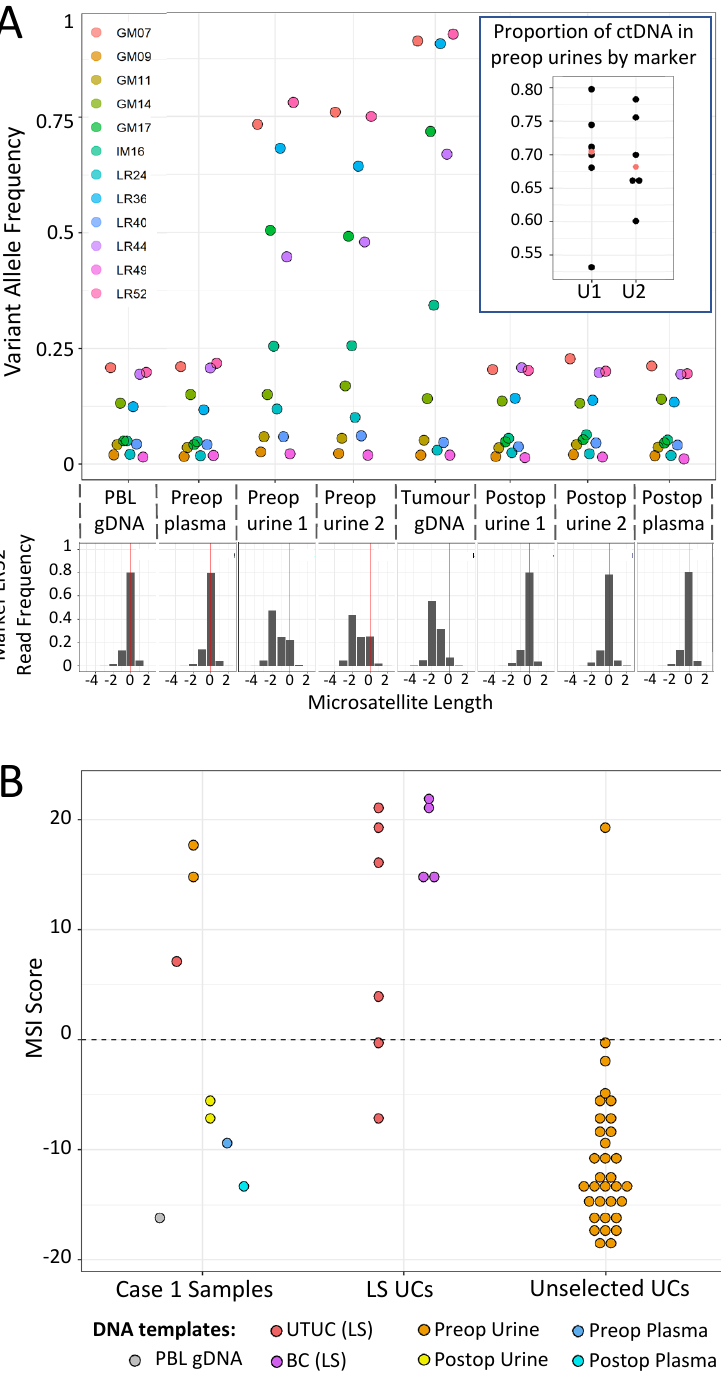
Figure 4. Analysis of Case 1 (LS UTUC patient) samples with the mPCR assay. ( A ) Top —VAFs for all 12 markers in patient samples (key gives marker names). Inset—Dot plot showing proportion of tumour-derived DNA within preop urine samples, based on 6 markers with increased VAFs. The median value is shown in red. Bottom —example of relative read frequencies of microsatellite lengths for 1 marker, LR52 (reference allele length = 0). ( B ) MSI scores of samples from Case 1 (left), UCs from genetically confirmed LS patients (centre), and preop urine samples from unselected UC patients (right). For details of samples, MSI scores, and read/barcode numbers, see Table S3.